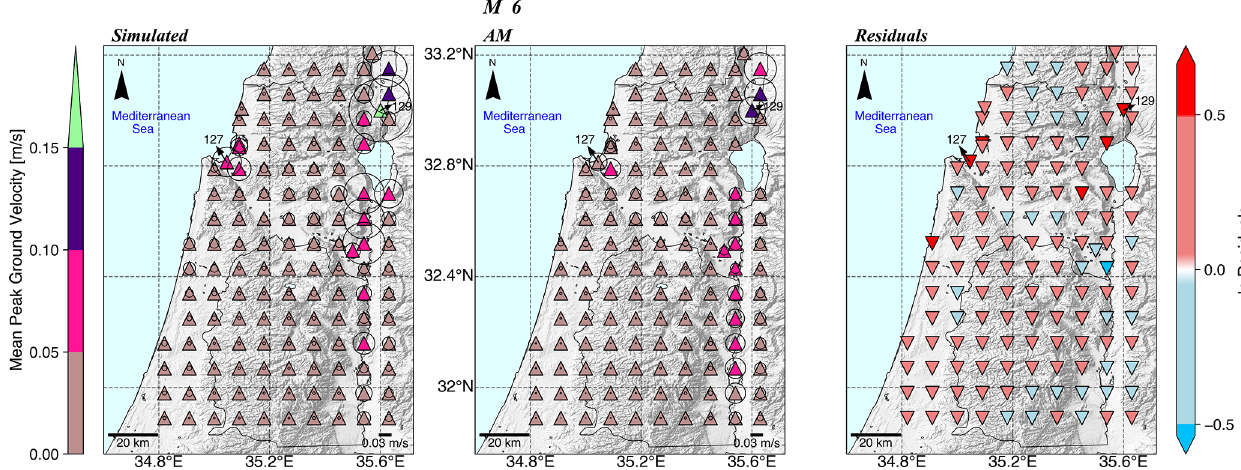
Figure 7. Map view of simulated and AM mean PGVs (triangles) for M 6 and their standard deviation (diameter of the circles) at each station, with the respective residuals in ln units (inverted triangles).